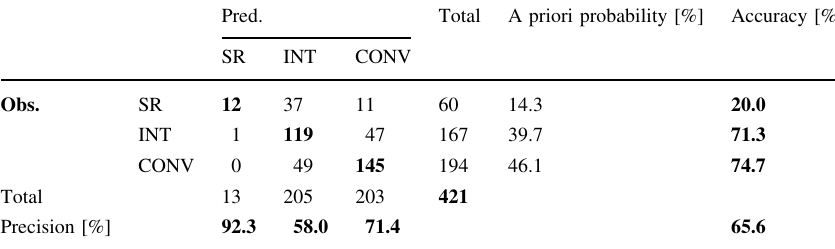
Table 18 Classification quality of the classification tree method